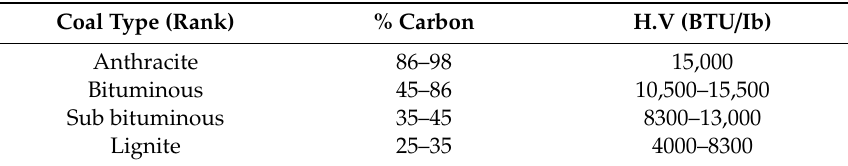
Table 1. Type of coal and percentage of